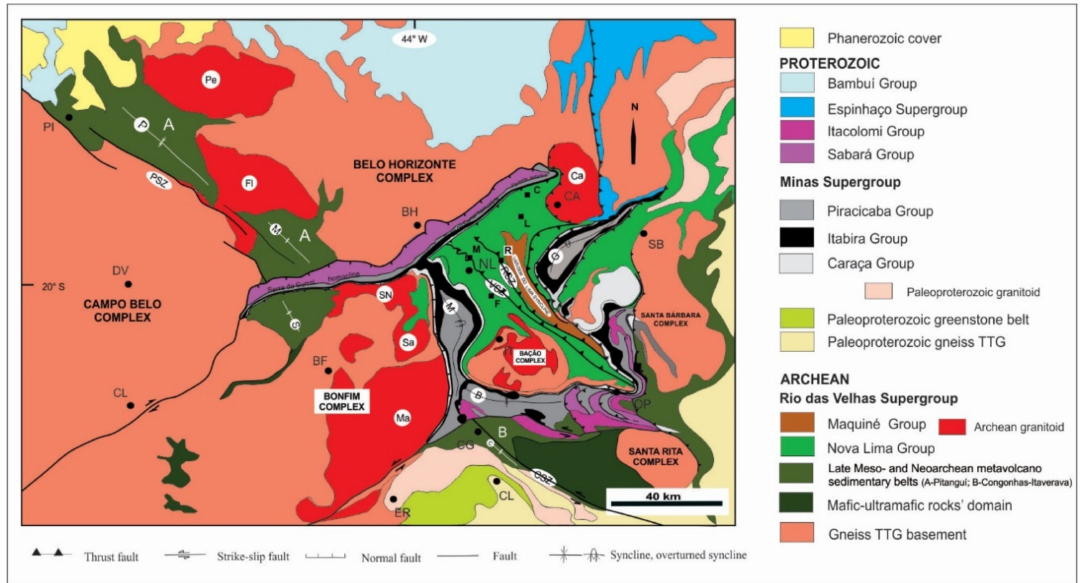
Figure 2. Geological map of the Quadril á tero Ferr í fero and surroundings (modified from [19]). Batholiths and